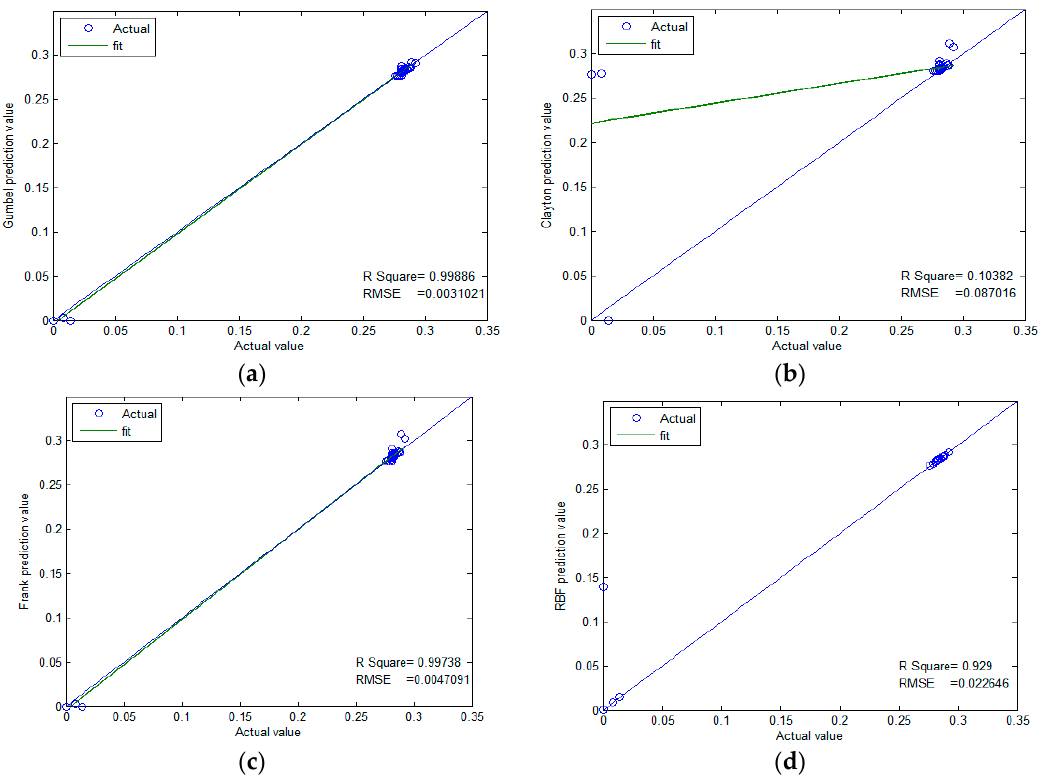
Figure 12. Comparison of correlation coefficients through four methods. ( a ) Gumbel-copula; ( b ) Clayton-copula; ( c ) Frank-copula; ( d ) RBF-ANN. ( b ) Clayton-copula; ( c ) Frank-copula; ( d ) RBF-ANN.